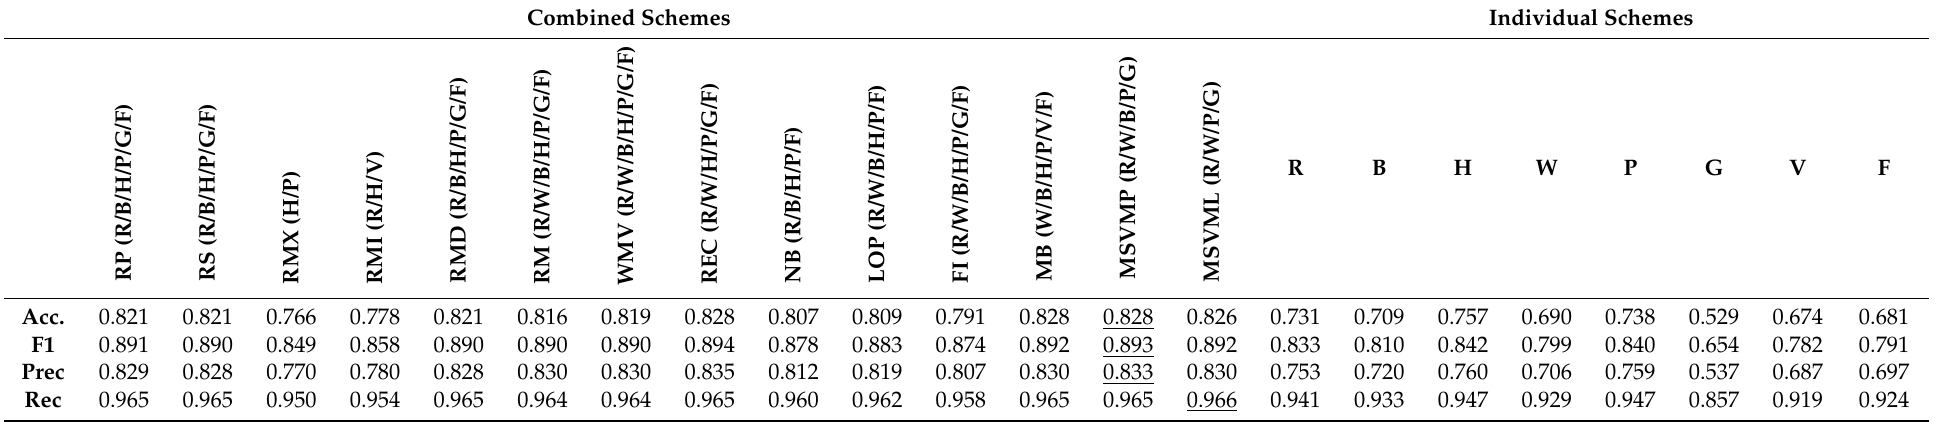
Table 7. The best schemes for each combination rule ( e · 1000 − 1 ) for the BU-3DFE data set. Acc: accuracy; Prec: precision; Rec: recall. Best classifier result is